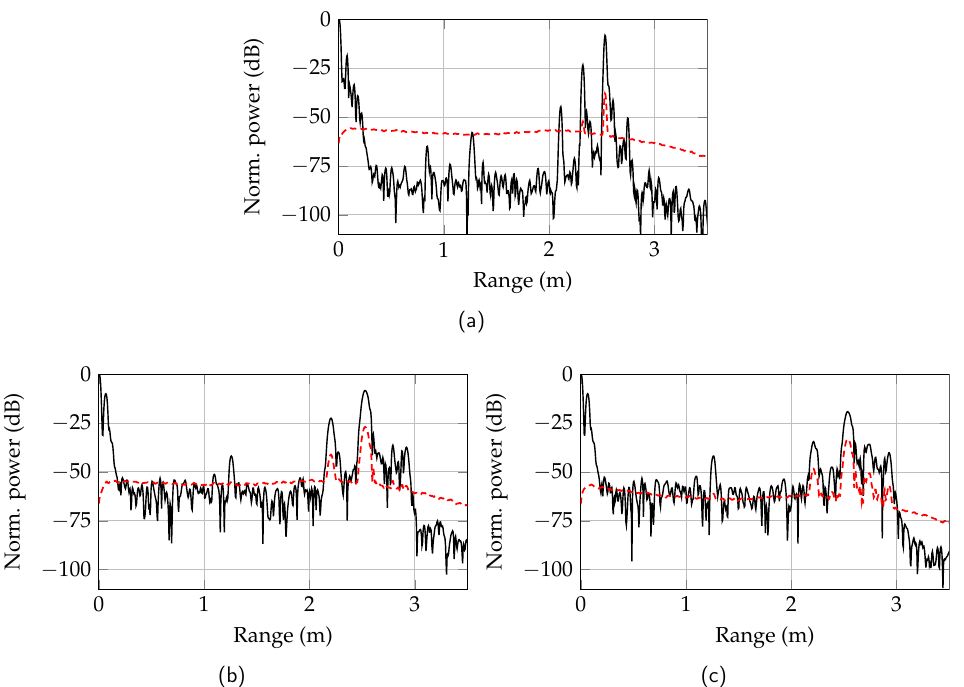
Figure 11. Mean value (—) and standard deviation (- - -) of the range spectrum of a free-space radiating radar with an extended metal plate target ( a ), the RTG with an metal cuboid target ( b ), and an metal cylinder target ( c ).